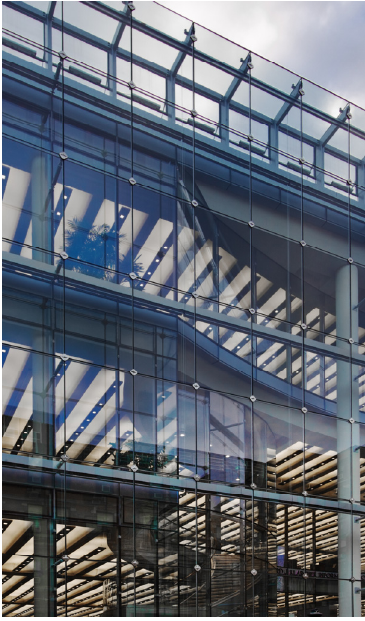
Figure 17. Transsolar Project—Loyola Info Commons: Reprinted with permission from © 2008, James Steinkamp, Steinkamp Photography, © Solomon Cordwell